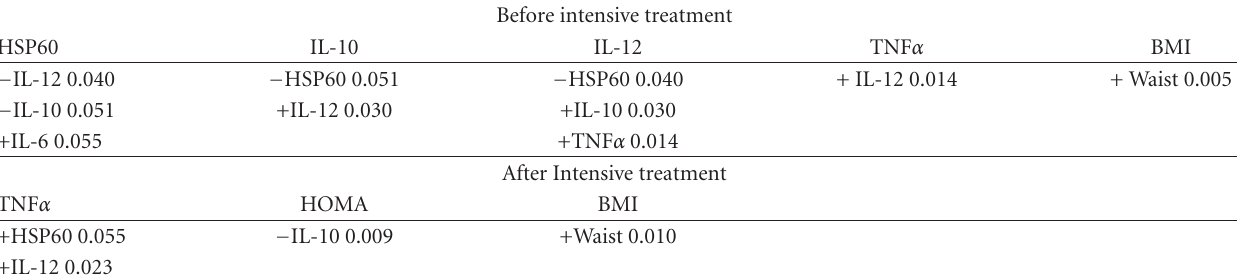
Table 2: Significant Pearson correlations for clinical factors and inflammatory markers change with treatment.